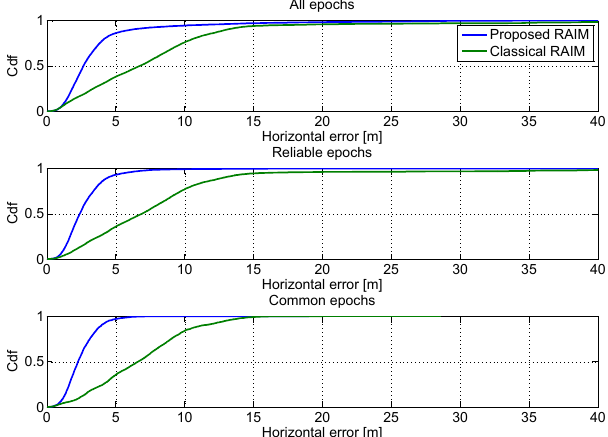
Figure 22. CDFs of the vertical position errors when a classical RAIM approach is considered. Upper box: CDFs computed using all available epochs; central box: CDFs computed using only reliable epochs; lower box: CDFs computed using only reliable common